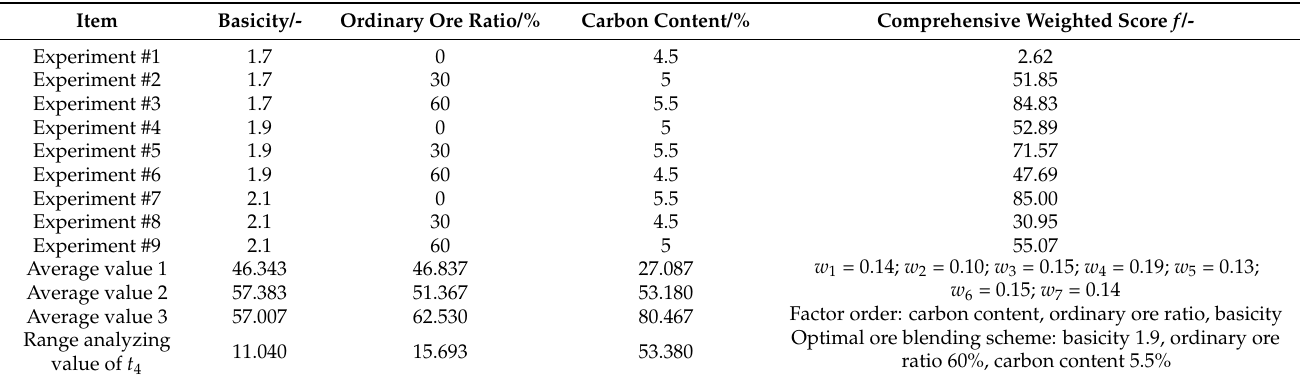
Table 15. Comprehensive weighted scoring